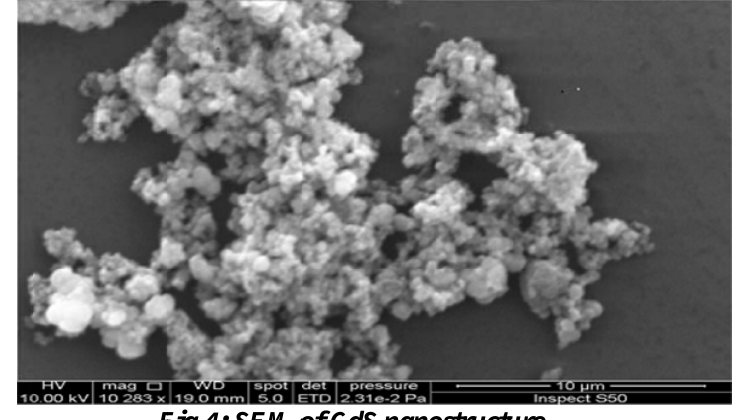
Fig.4: SEM o Fig.5: The